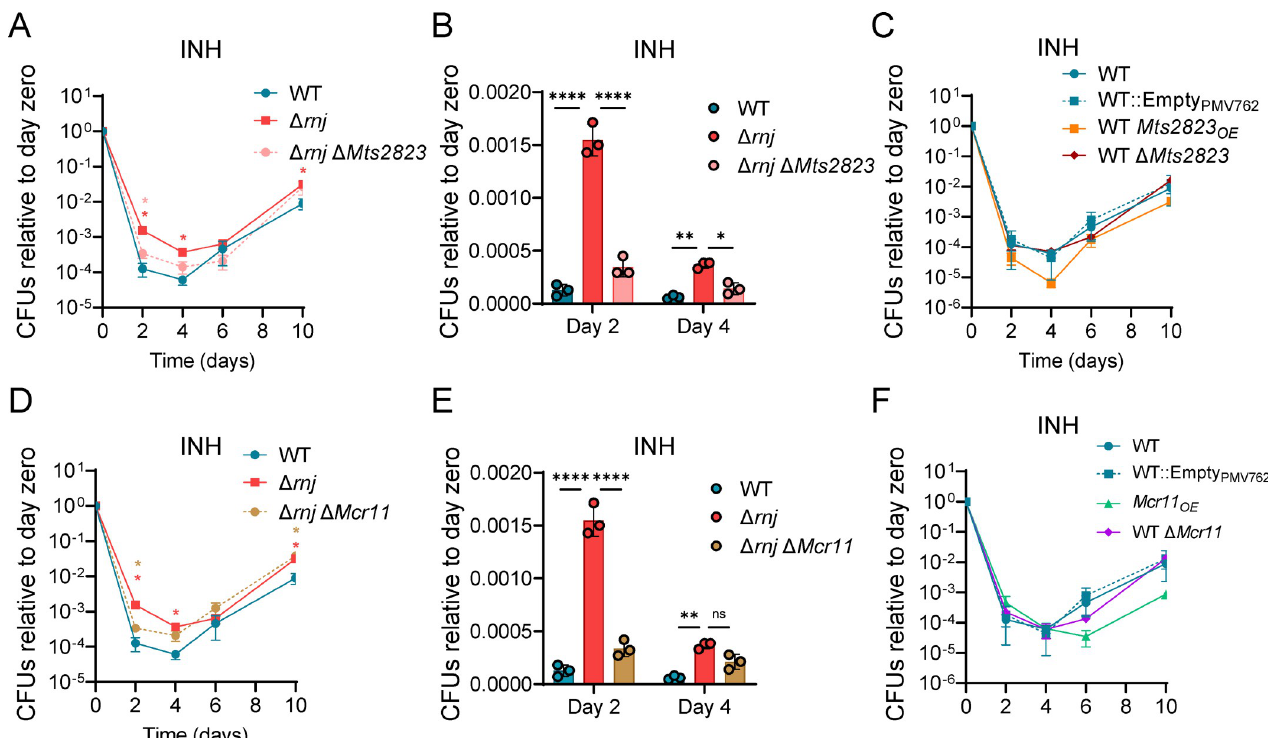
Fig 5. Overexpression of the sRNAs Mts2823 and Mcr11 is necessary but not sufficient for INH tolerance in Δ rnj Mtb. Time-killing curves in presence of INH (2.4 μ g/mL) for strains with deletion or overexpression of Mts2823 (A-C) or Mcr11 (D-F) strains are shown. � p < 0.05, �� p < 0.001 two-way ANOVA. Pink stars: comparison of Δ rnj Δ Mts2823 to Δ rnj . Red stars: comparison of WT to Δ rnj . Tan stars: comparison of Δ rnj Δ Mcr11 to Δ rnj .